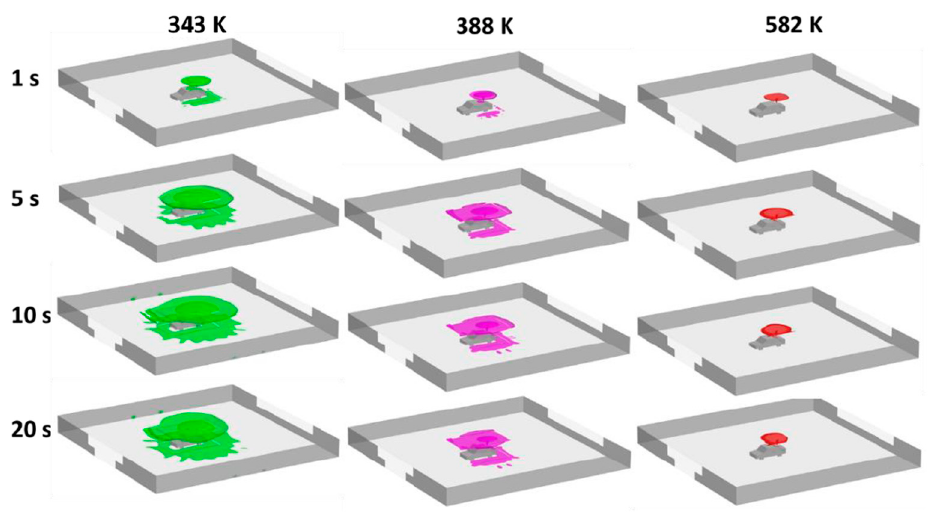
Figure 9. Iso-surface showing no-harm (343 K), pain limit (388 K) and fatal limit (582 K) temperature for ignited hydrogen release in case 8 (TPRD = 0.5 mm, upward release with tank blowdown from distance 1.13 m to the ceiling, and car body).